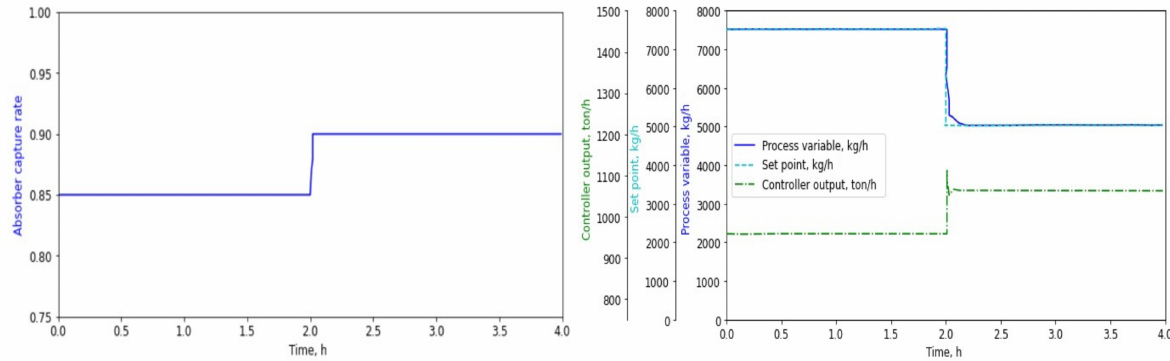
Figure 6. Absorber parameters in response to change in capture rate.